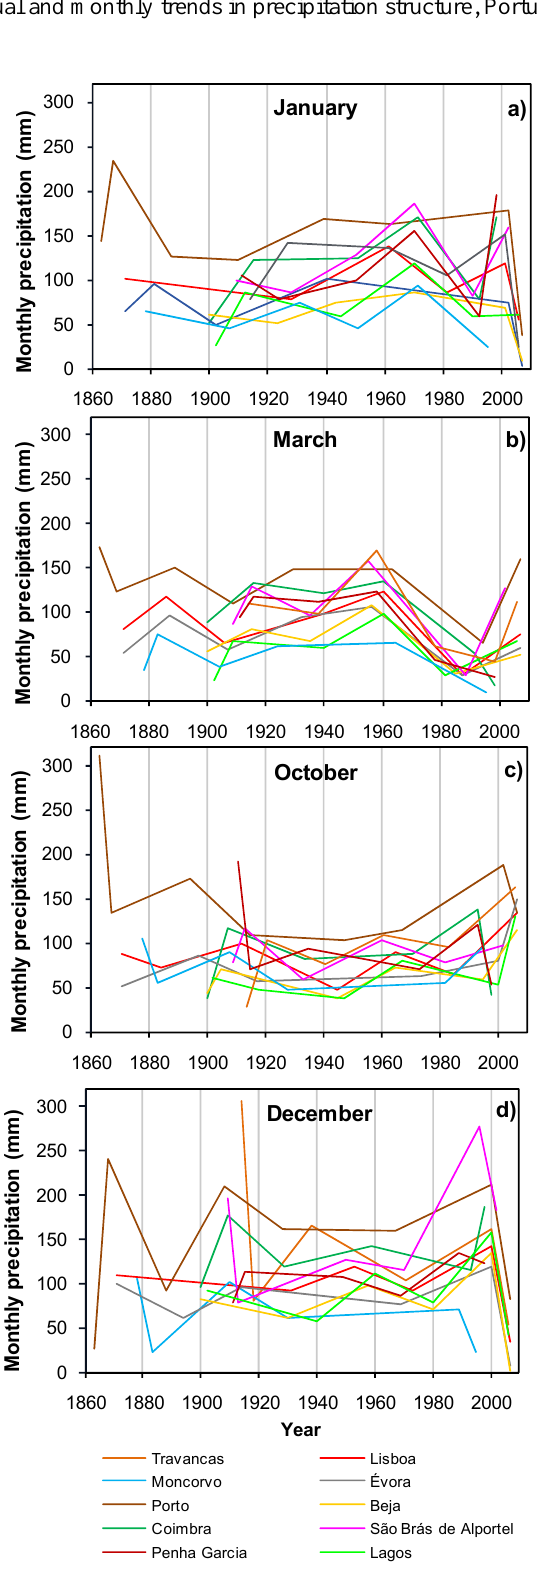
Fig. 6. Partial trends in monthly precipitation in mainland Portugal: (a) January; (b) March; (c) October; (d) December. The time series are not plotted.